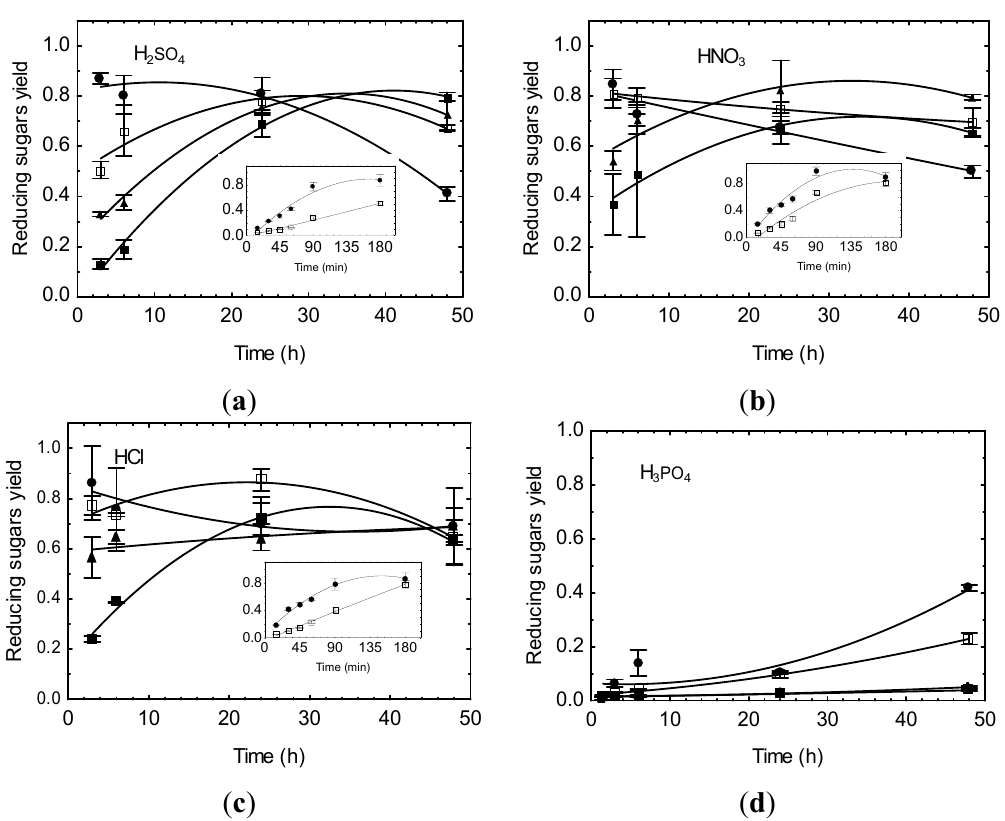
/g total sugars) kinetics from the hydrolysis eq SO ; ( b ) HNO ; ( c ) HCl; and ( d ) H 2 4 3